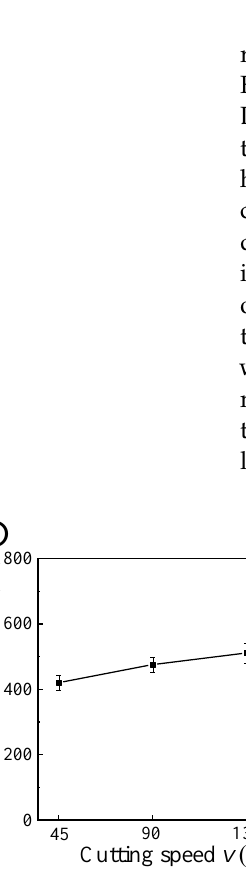
Figure 7. Cutting temperatures obtained under different cutting parameters: ( a ) cutting speed, ( b ) feed rate, and ( c ) cutting depth.